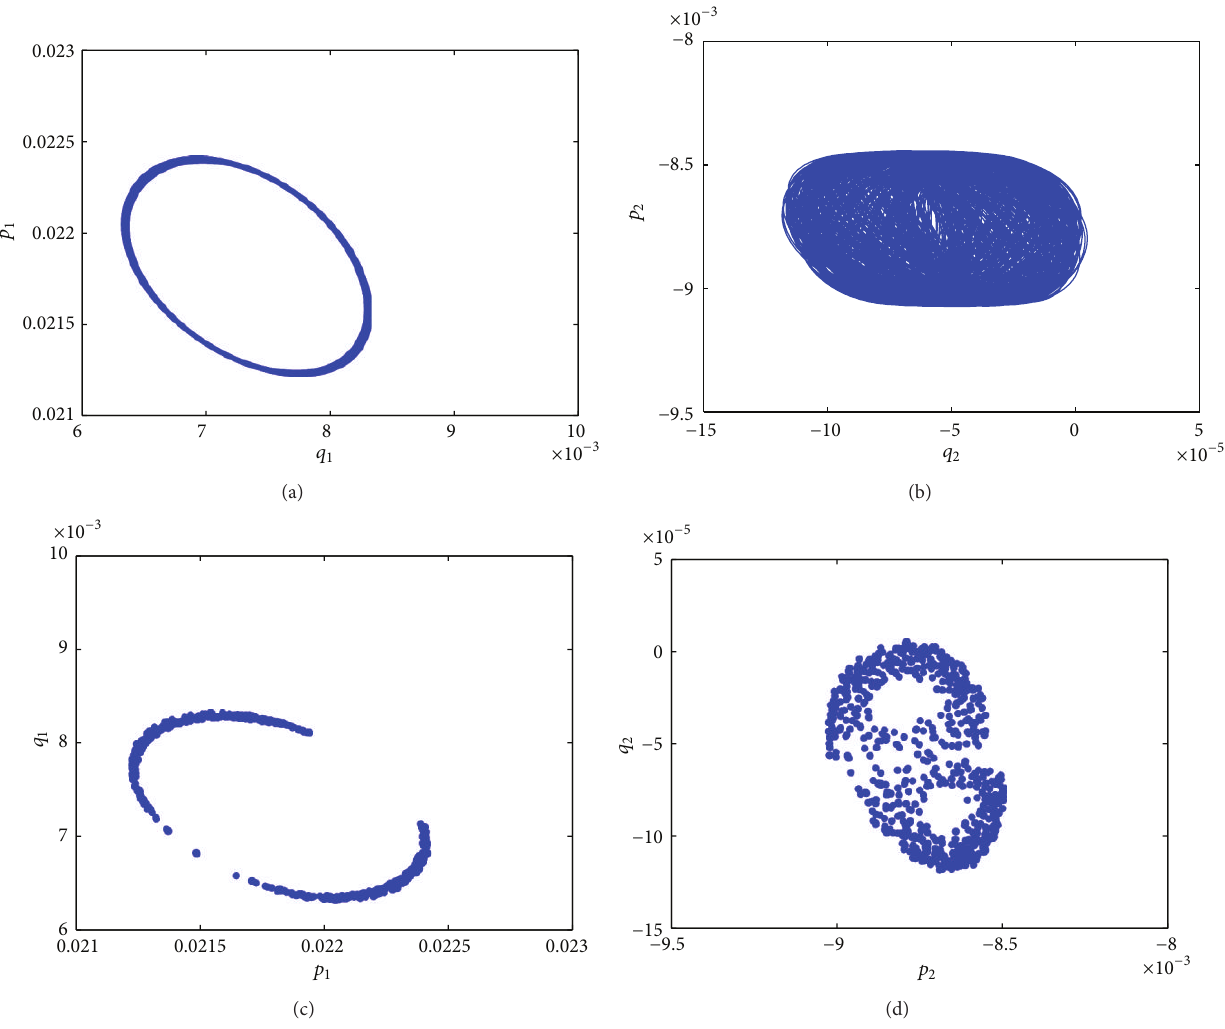
Figure 12: Phase portraits (a, b) and Poincare maps (c, d) for 𝜎 2 = 78.2799 , 𝜇 = 0.05 , V 1 = 10 , 𝛼 = 0 , and 𝜎 1 = 92.39